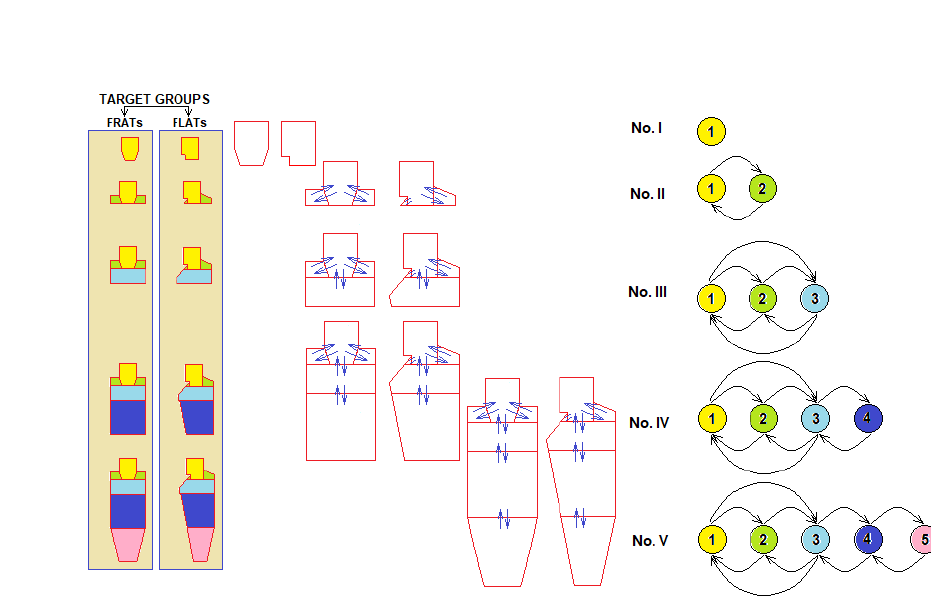
Figure 7 – The implementation of the third graph-model for five FRATs and five